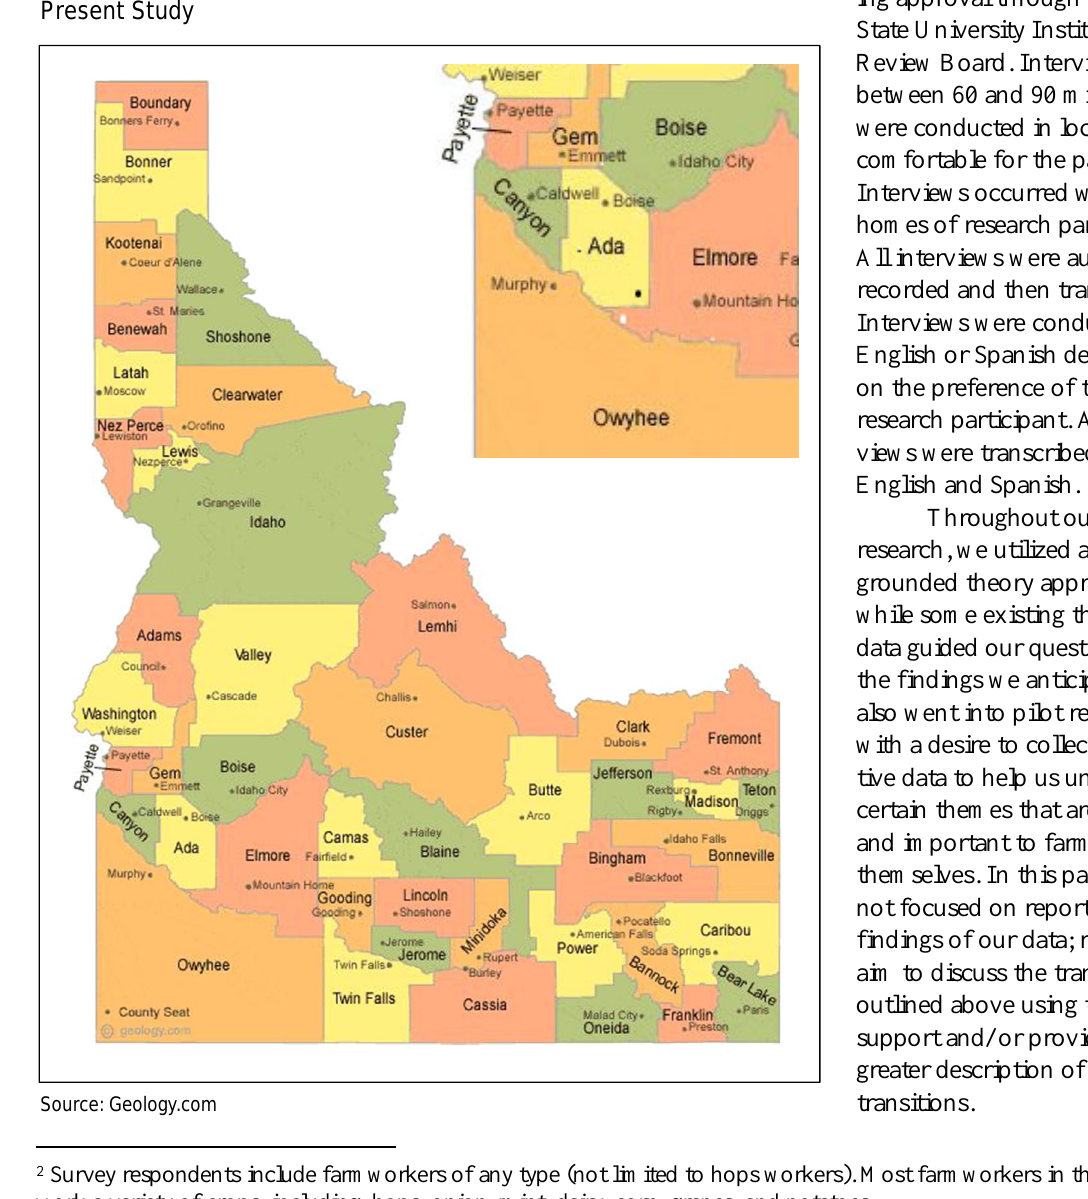
Figure 1. Map with Inset of the Regional Focus Area of the Present Study